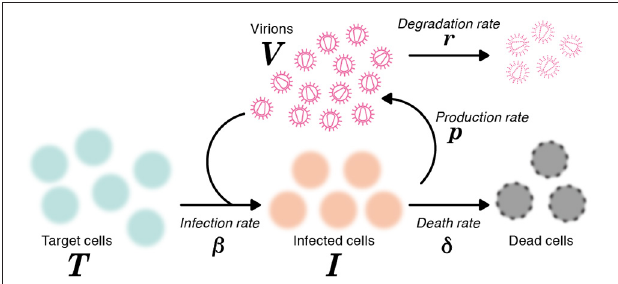
FIGURE 1 | A schematic representation of the mathematical model. The variables T and I are the number of target and infected cells, respectively, and V is the number of RNA copies of virus. The parameters δ , c , β and p represent the death rate of infected cells, the degradation rate of viral RNA, the rate constant for infection of target cells by virus, and the viral production rate of an infected cell,